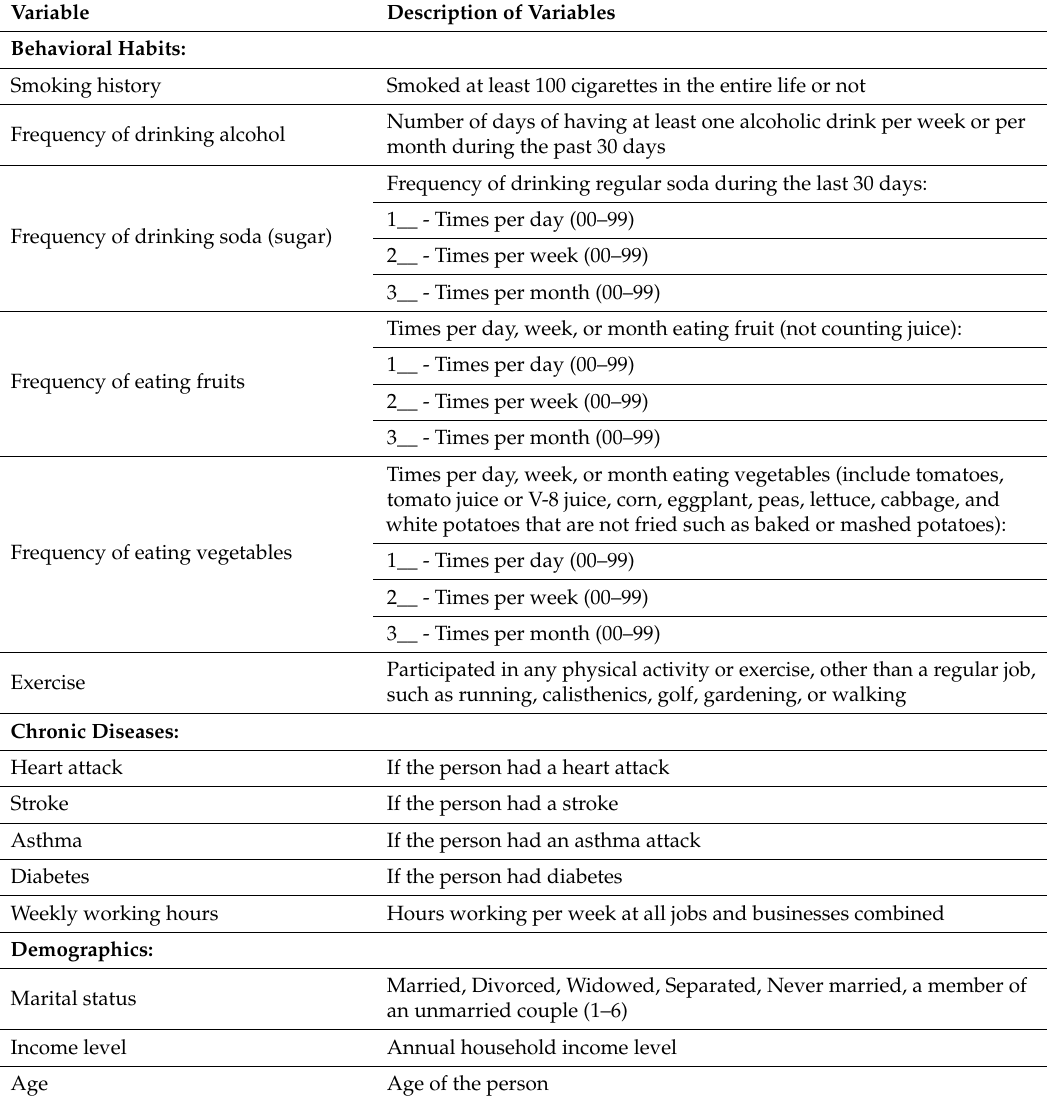
Table 1. Variables in the